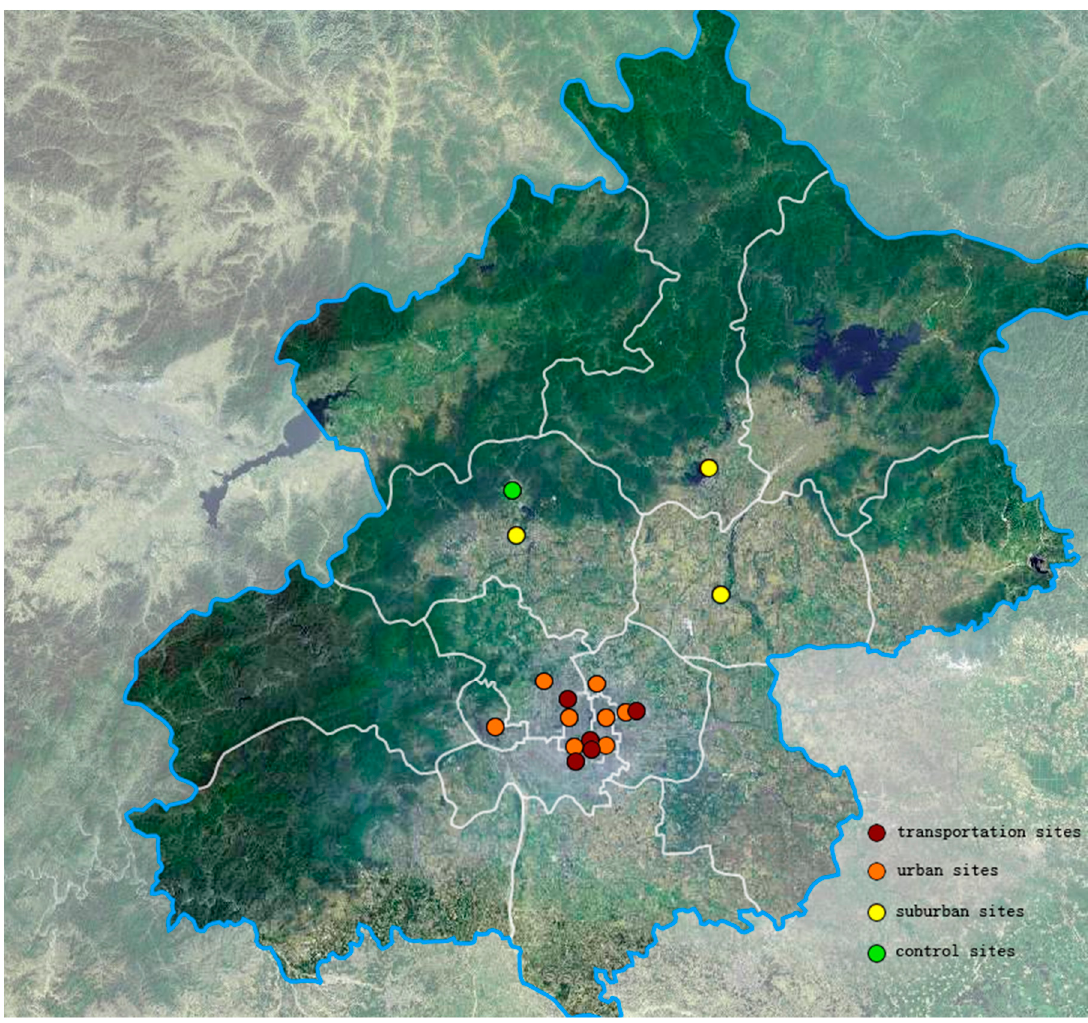
Figure 1. Distribution of monitoring sites.